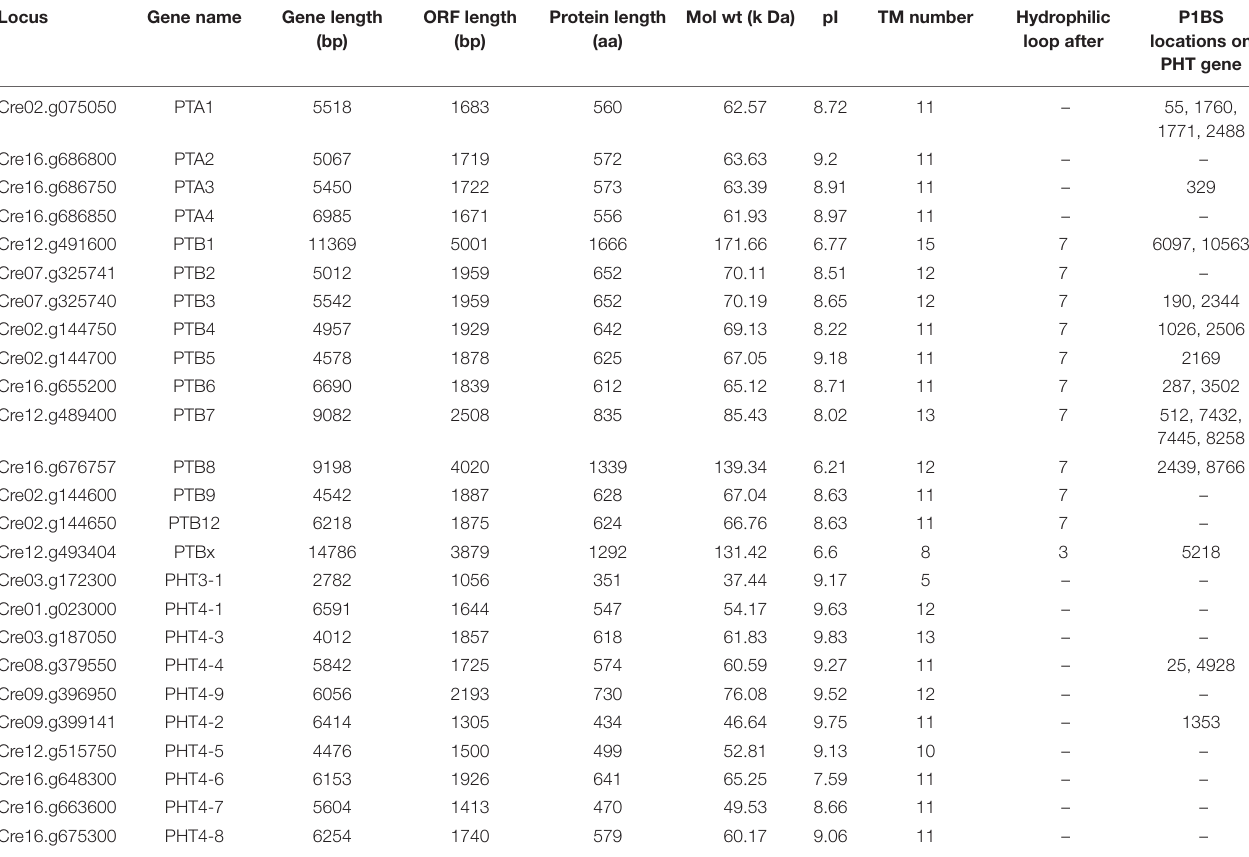
TABLE 1 | Key features of all 25 PHTs in Chlamydomonas reinhardtii .